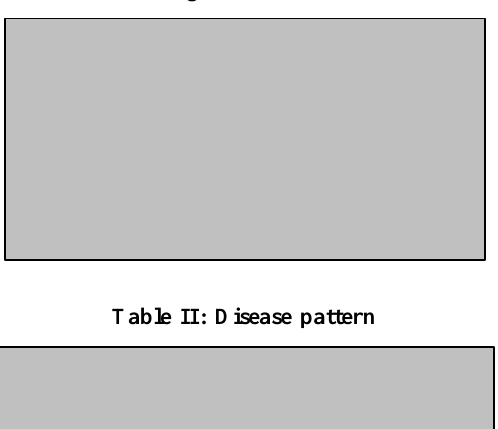
Table II: Disease